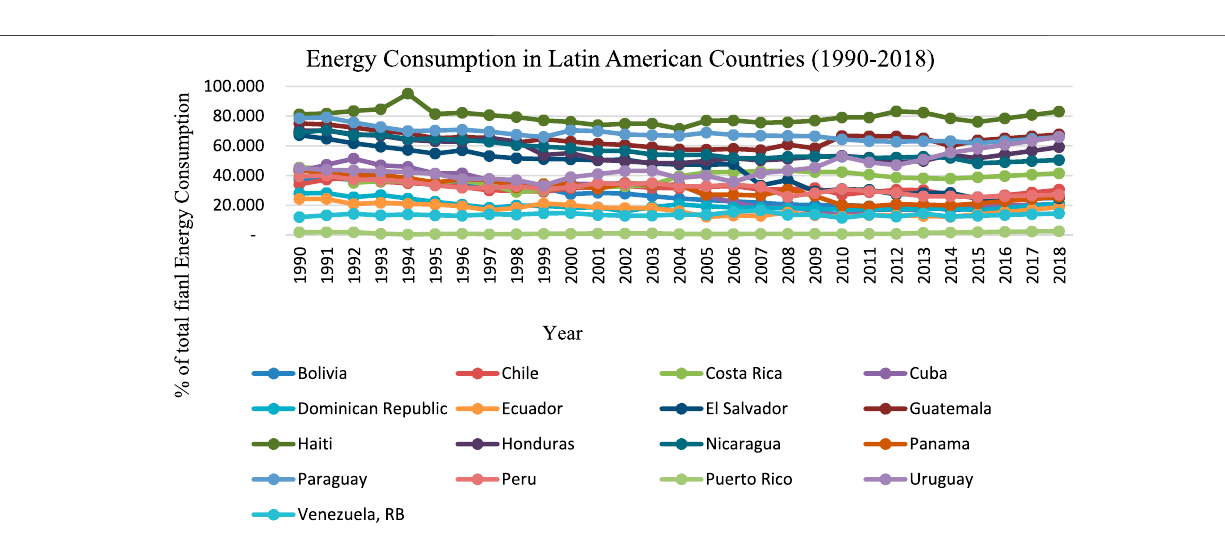
FIGURE 4 | Energy consumption of Latin American